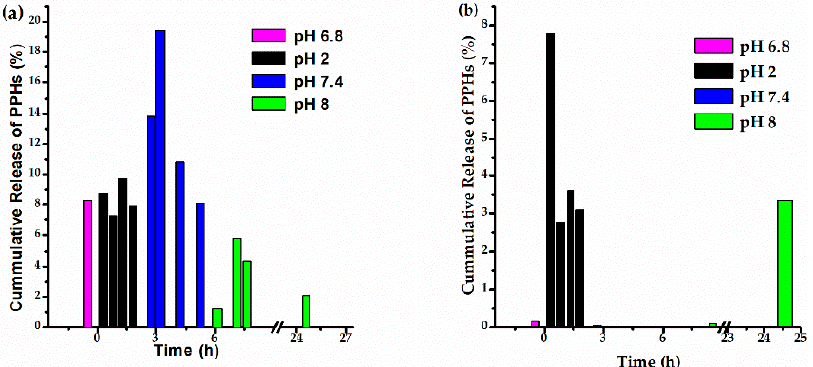
Figure 11. Cumulative release profiles of PPHs from CS- b -PPEGMA ( a ) and CS ( b ). Note: the cumulative release is only within a pH value; after every pH change, a new cumulative release is calculated.